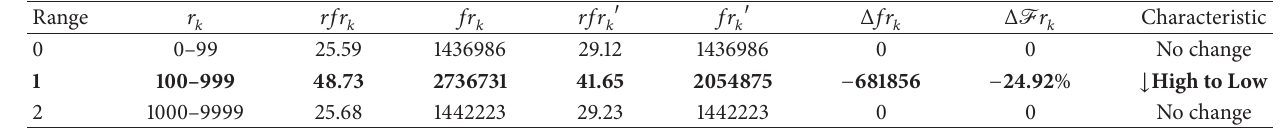
Table 15: Characterization of malicious deletion attacks on range of data values.